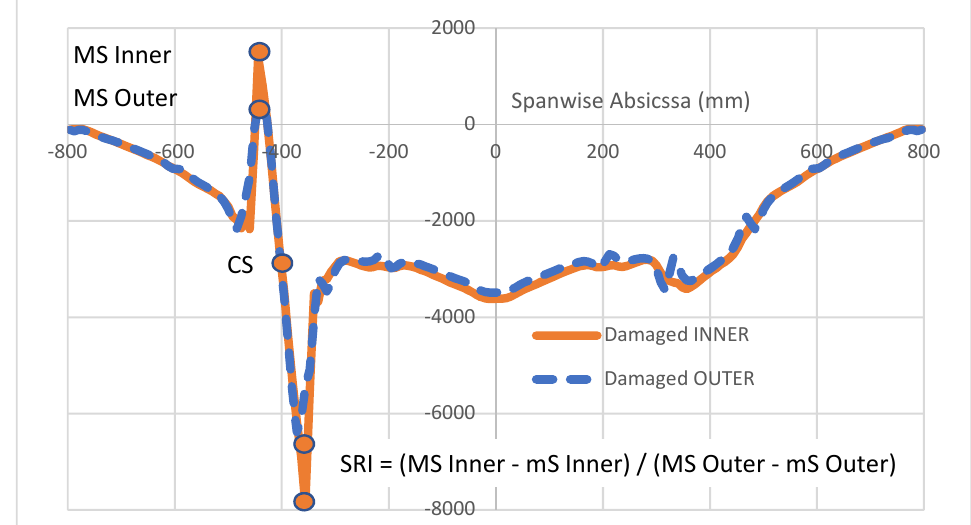
Figure 12. Strain deviation parameters, [36].